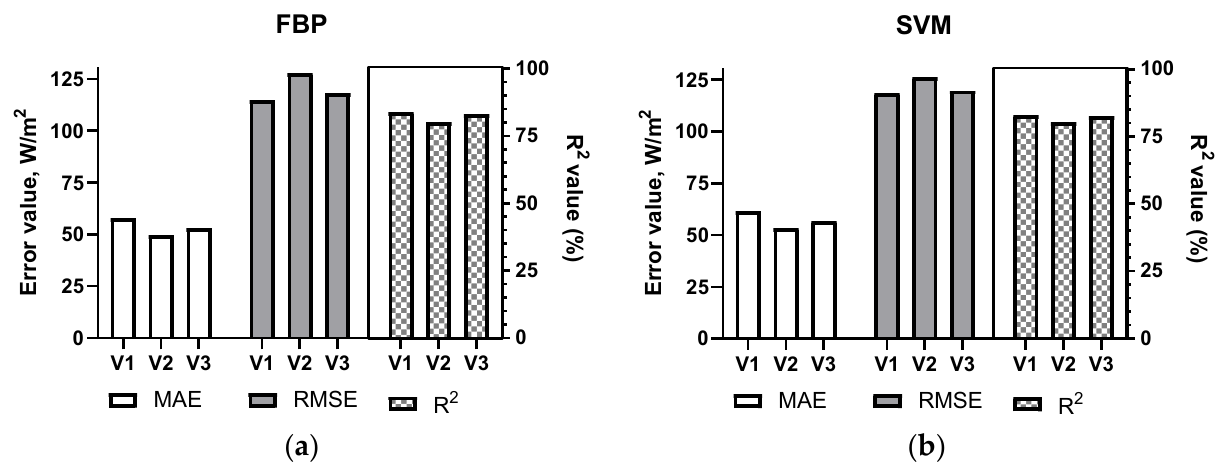
Figure 9. Comparison of ( a ) FBP and ( b ) SVM of seasonal adaptation versions.